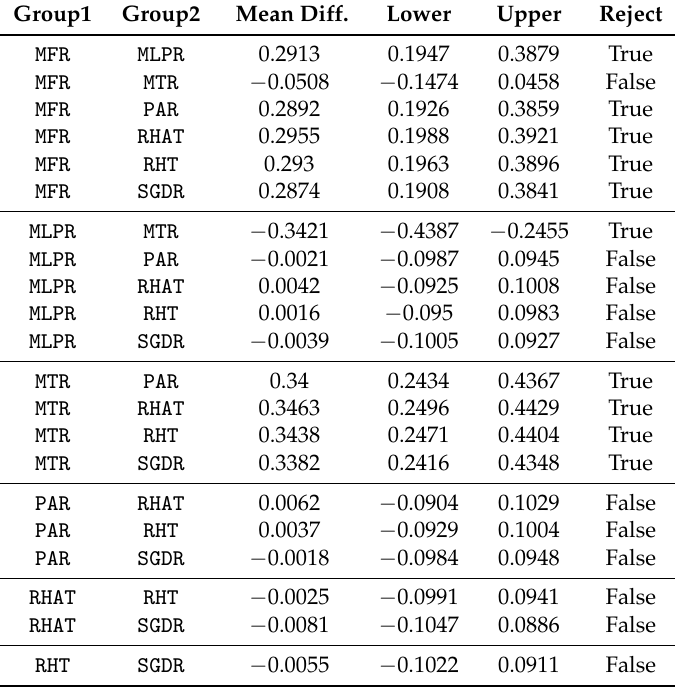
Table 14. Results of the Tukey’s range test for experiment 3.